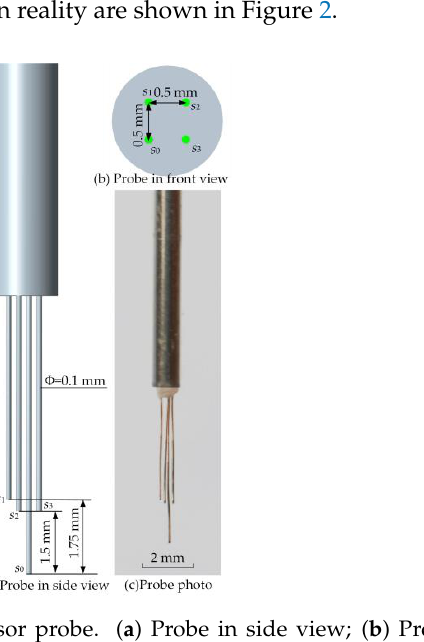
Figure 2. Dimensions of the four-sensor probe. ( a ) Probe in side view; ( b ) Probe in front view; ( c ) Probe